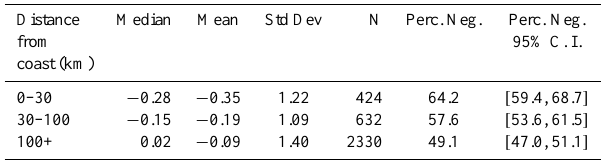
Depth-averaged (0–300m) oxygen trend